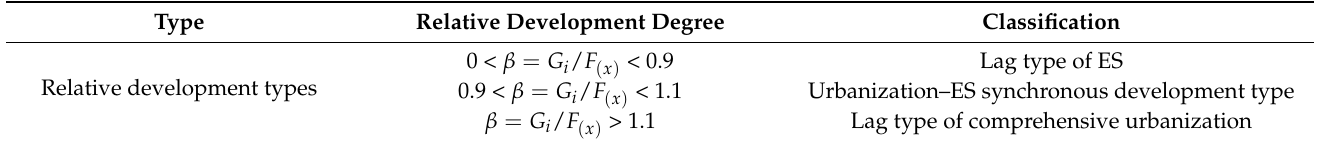
Table 4. Classification criteria of relative development types of ESs and comprehensive urbanization. Type Relative Development Degree